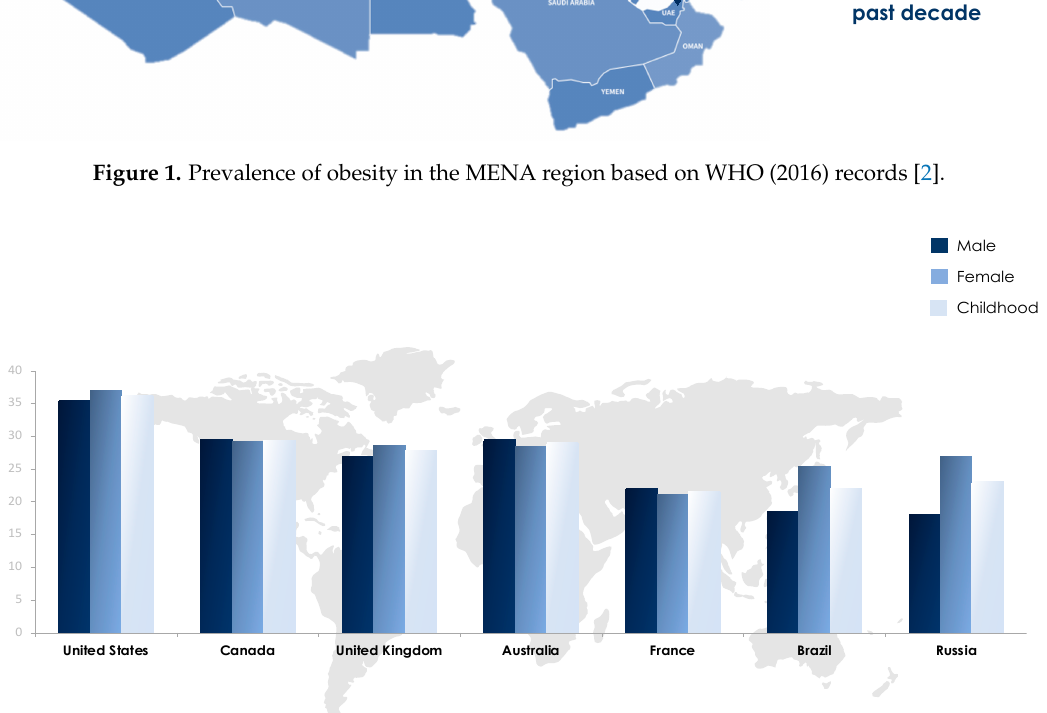
Figure 2. Prevalence of obesity in selected countries worldwide based on WHO (2016) records